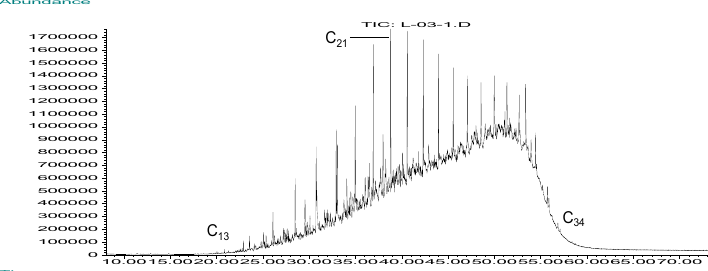
Figure 2. Chromatogram of sample